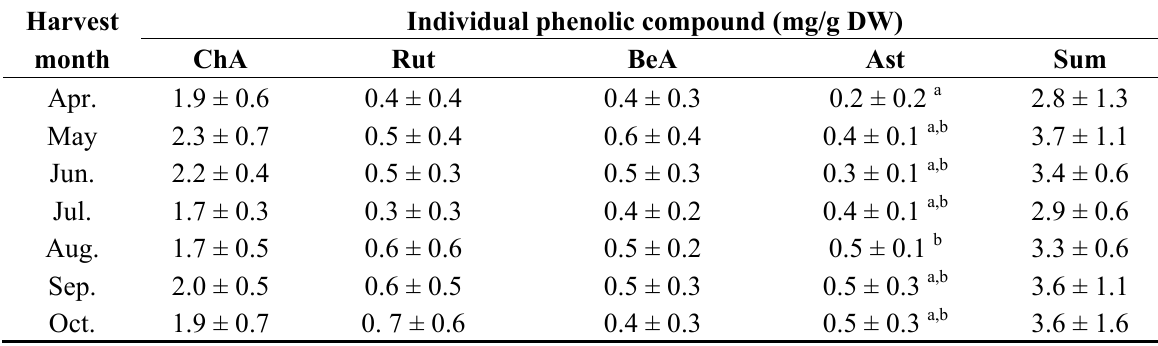
Table 4. Effect of harvest month on 4 phenolic compounds in mulberry